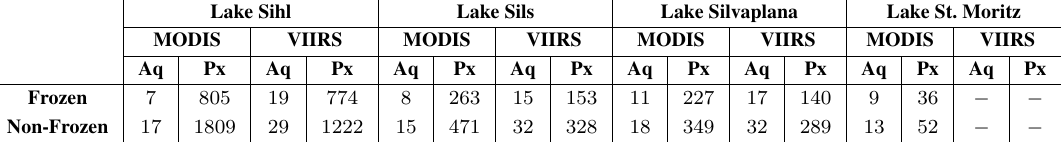
Table 2: Available ground truth data on cloud-free dates processed in winter 2016 - 17 . Frozen data comprises of the acquisitions from February 2017 , non-frozen data from October 2016 and December 2016 . Only the first half of December 2016 are processed. The table shows the total number of clean , cloud-free pixels (Px) and the total number of acquisitions (Aq) which are > 30% cloud-free.